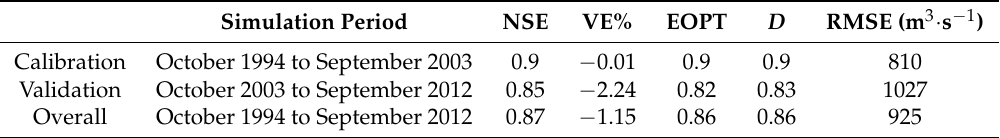
Table 5. Calibration and validation results of the UBC model applied over the UIB at Besham